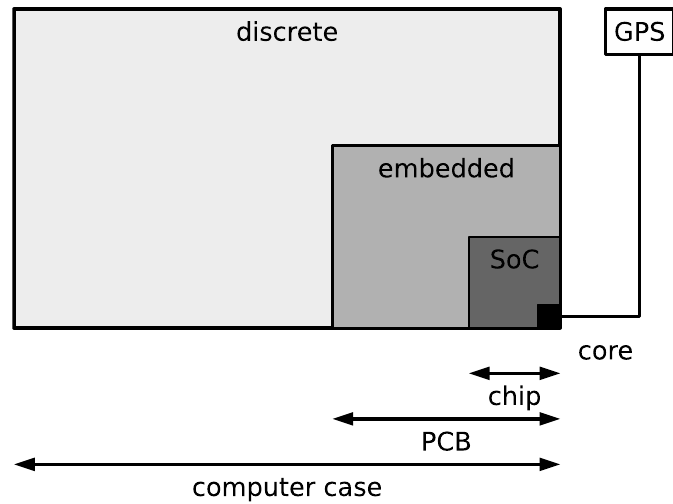
Figure 1. Qualitative physical scale comparison of time server implementation approaches from discrete equipment to hardware core (this paper). Unit cost and power consumption roughly downscale with the physical